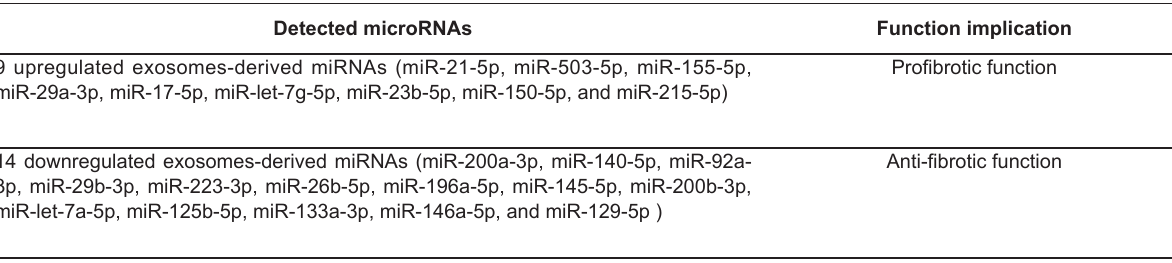
Table 1. Exosomes derived microRNA for